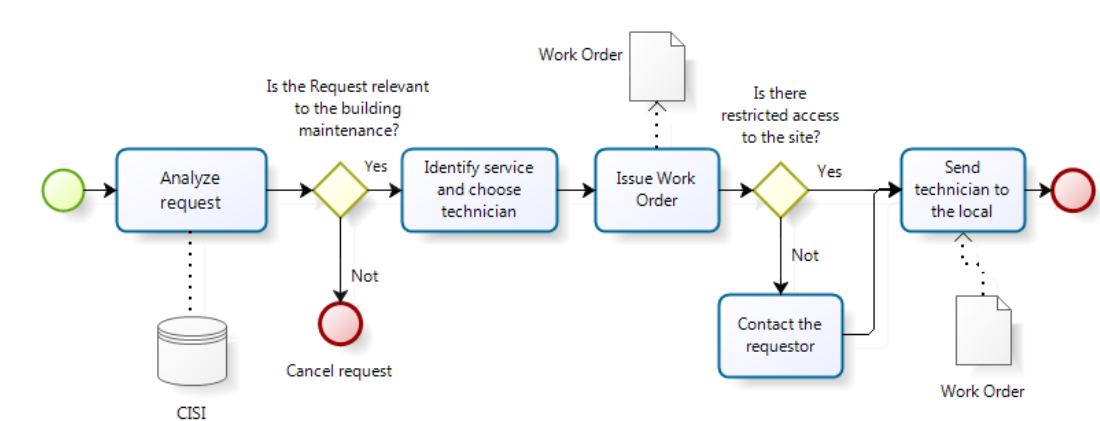
Figure 3. Example of the existing Business Process Management and Notation (BPMN) diagram representing the overall process of work order issuance for the building maintenance.